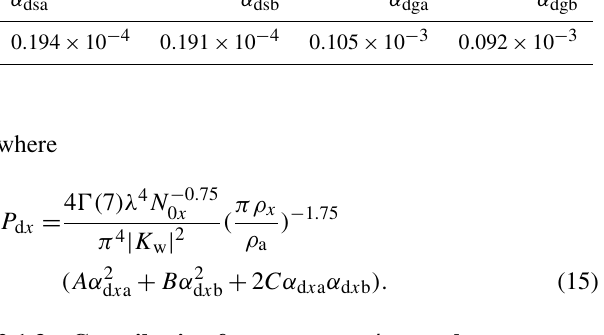
Table 1. Values of α dsa , α dsb , α dga , and α dgb . α